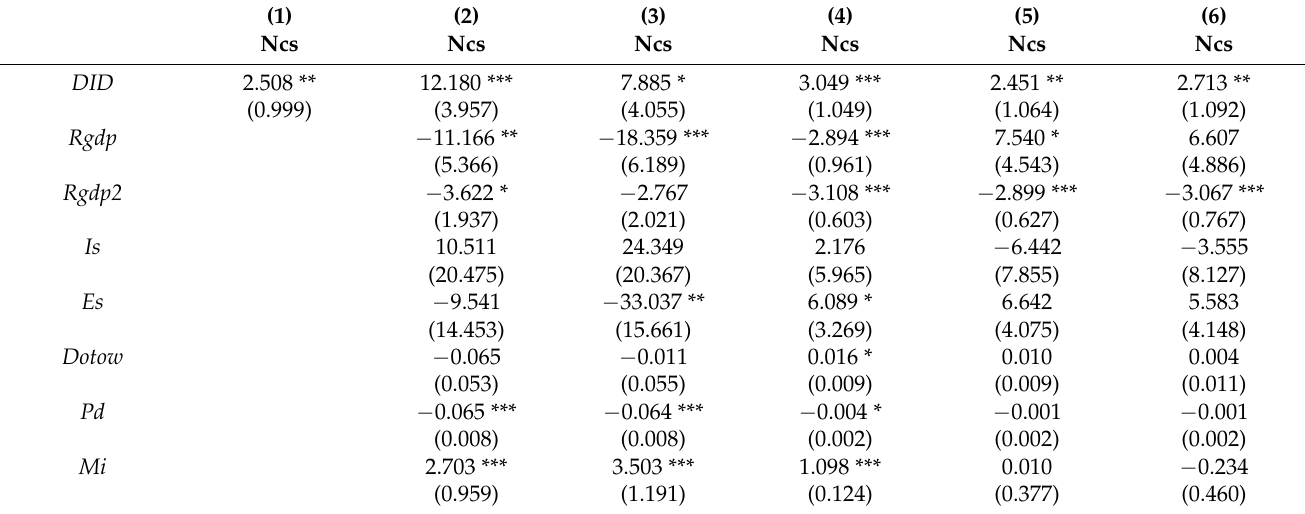
Table 2. Baseline